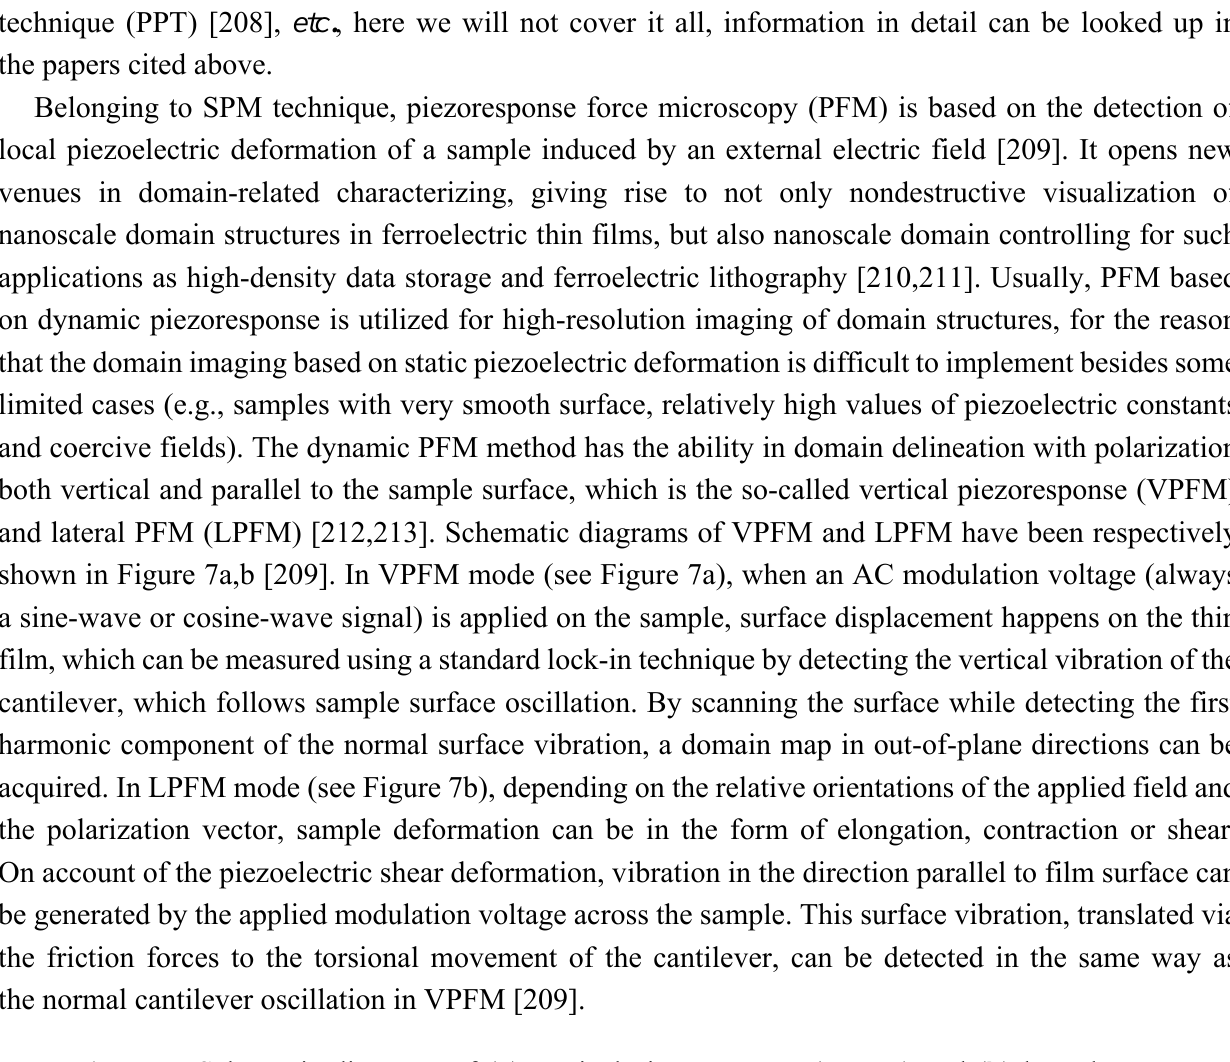
Figure 7. Schematic diagrams of ( a ) vertical piezoresponse (VPFM) and ( b ) lateral PFM (LPFM)